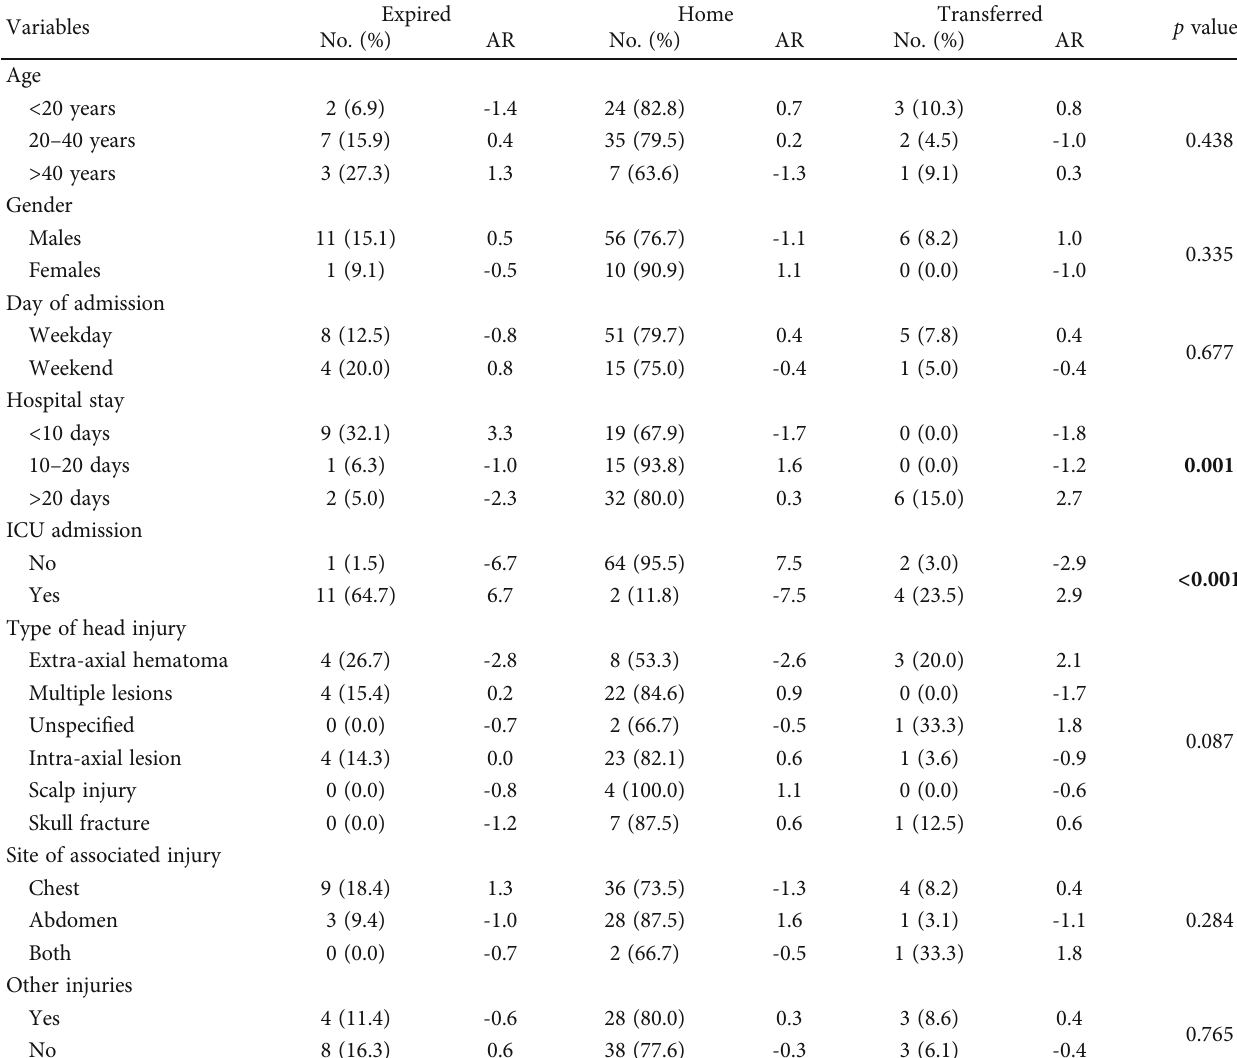
Table 5: Association between di ff erent variables and outcome of MVA-related HI with thoracoabdominal injuries ( n = 84 ). Variables